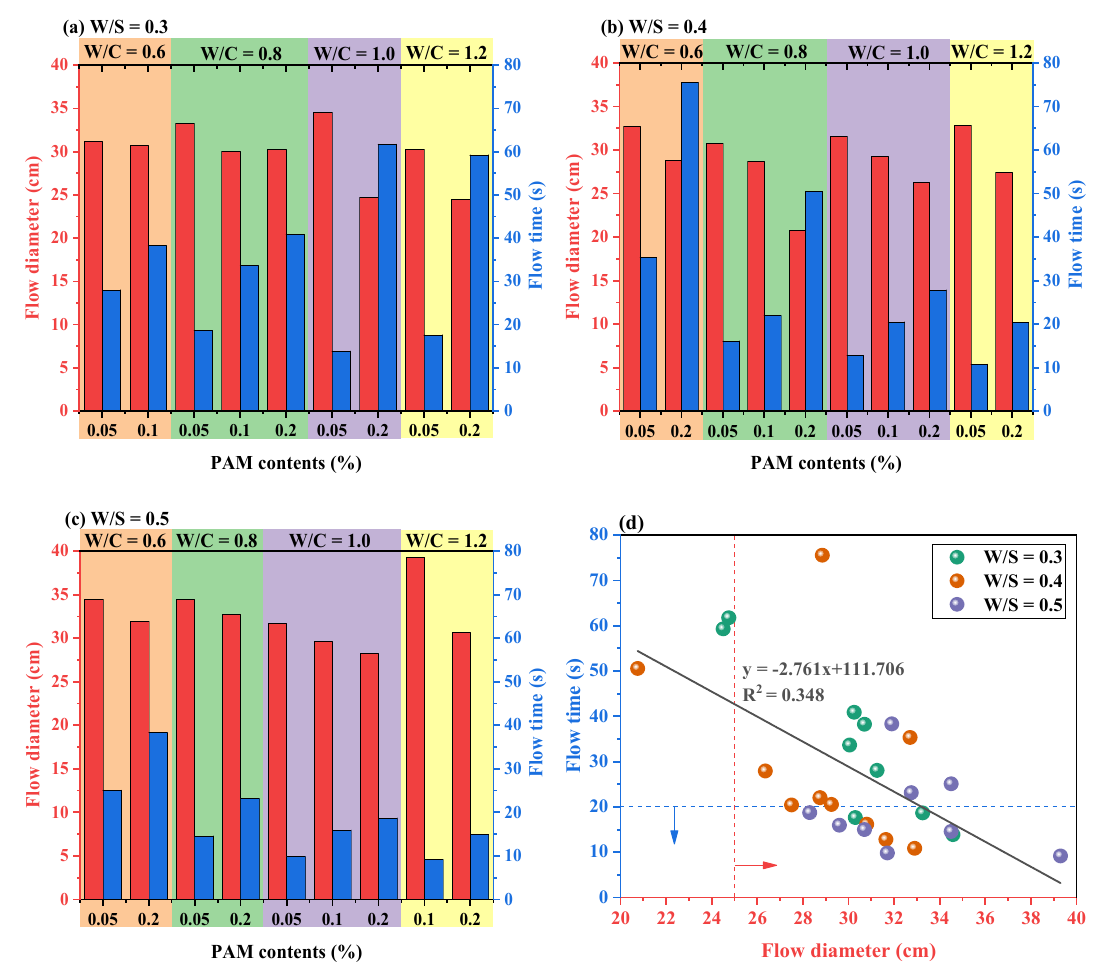
Figure 3. Flow diameter and flow time of fresh CPBs in ( a – c ); the fitting relationship of flow time vs. flow diameter in ( d ).